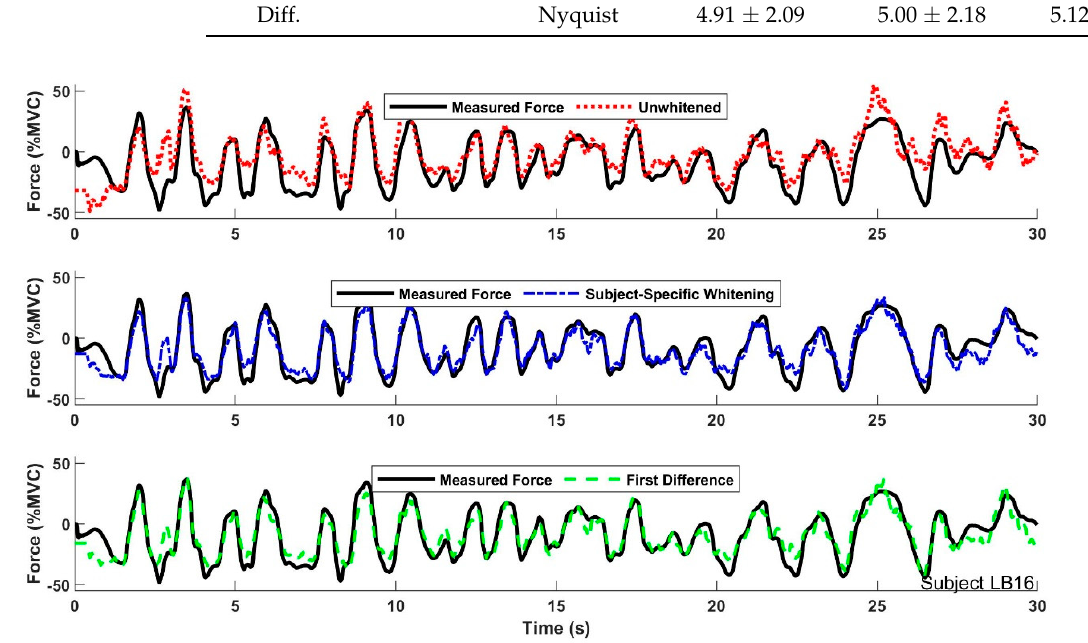
Figure 5. Example time-series plots from one trial showing measured force and EMG-force estimates using representative whitening variations. Each EMG-force processor used data sampled at 4096 Hz and RDS noise correction. The subject- specific whitener used adaptive noise canceling and a whitening bandwidth of 600 Hz. The first difference whitener used a whitening bandwidth of 600 Hz.